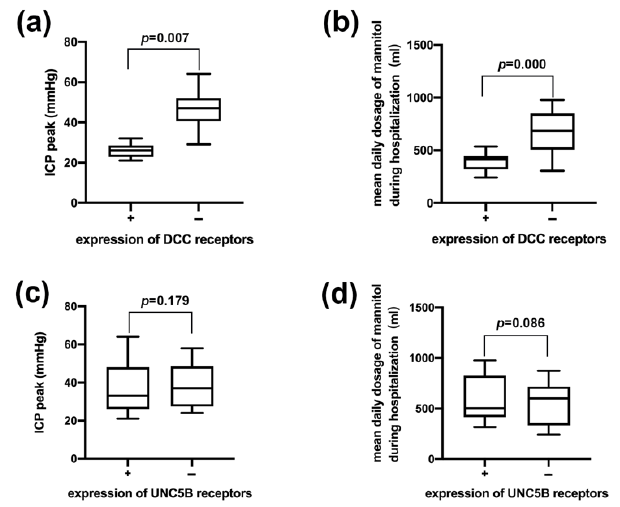
Figure 3. Comparisons of the postoperative intracranial pressure and sensitivity to dehydration therapy in patients with different expression of DCC receptors and UNC5B receptors. ( a ) Comparison of the postoperative intracranial pressure in patients with different expression of DCC receptors. ( b ) Comparison of the average mannitol consumption in patients with different expression of DCC receptors. ( c ) Comparison of the postoperative intracranial pressure in patients with different expression of UNC5B receptors. ( d ) Comparison of the average mannitol consumption in patients with different expression of UNC5B receptors. Table 5. Comparison of ICP level between the DCC-positive group and the DCC-negative group. Comparison of ICP level between the UNC5B-positive group and the UNC5B-negative group.